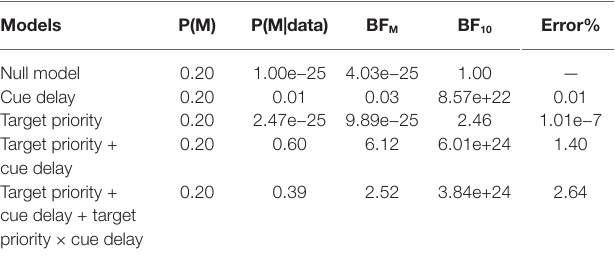
TABLE 1 | Model comparison for the Bayesian ANOVA on accuracy.